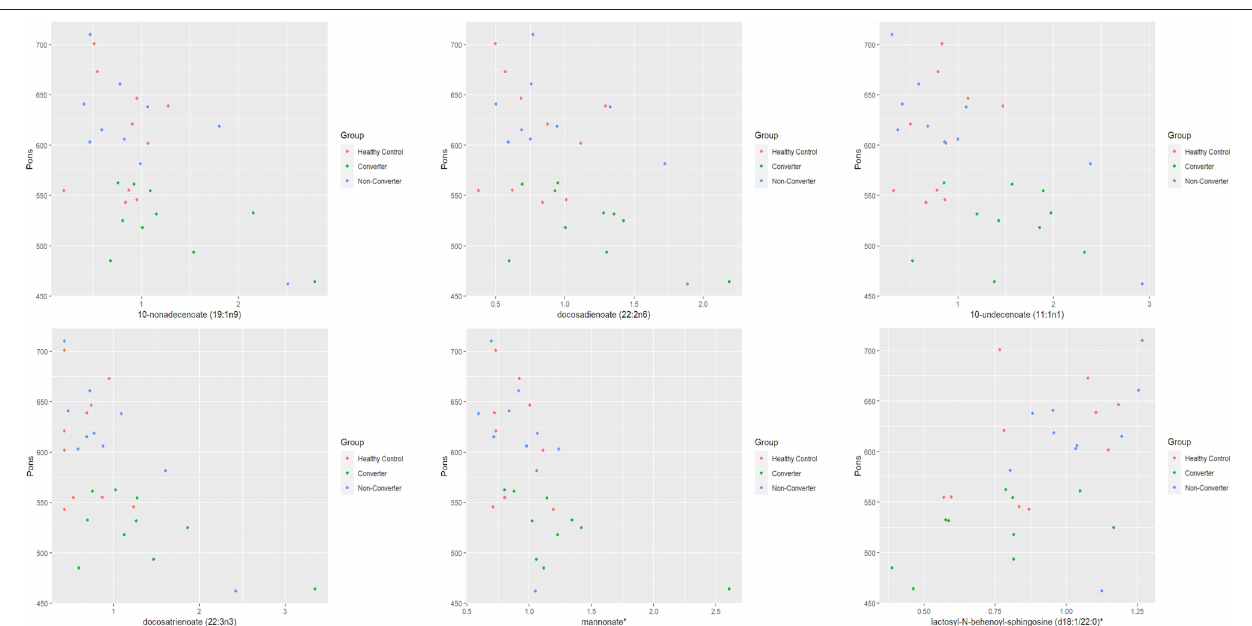
FIGURE 1 | Pons by metabolite expression among HC, CON and NCON. Scatter plots showing correlation between pons and metabolite expression levels. The dots in red are representing the plotted values obtained for HC, green for CONV and blue for NCON. *The identity of these metabolites has not been officially confirmed based on the